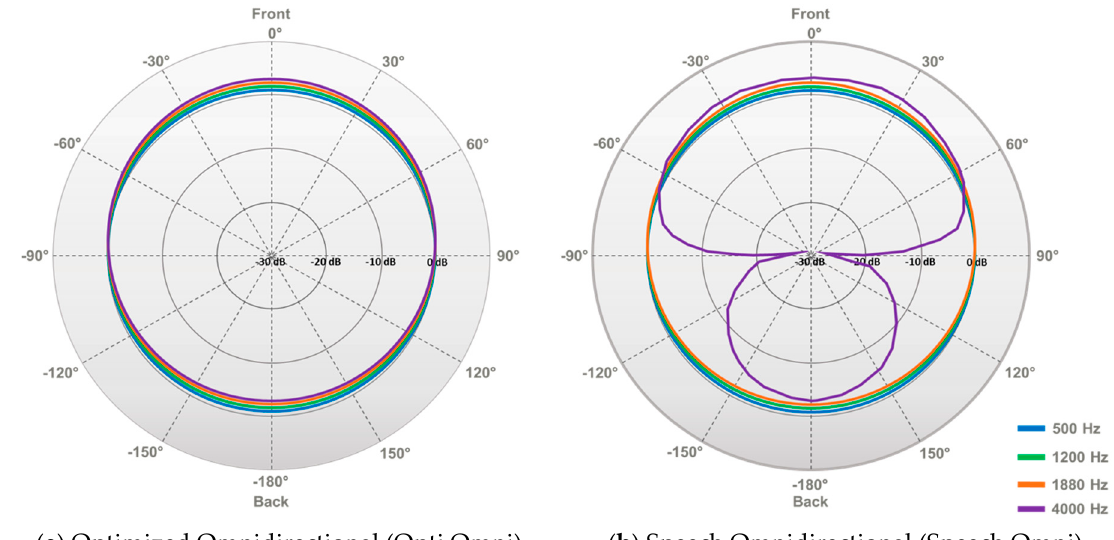
Figure 1. Polar patterns of the two modes ( a ) Optimized Omnidirectional (Opti Omni) and ( b ) Speech Omnidirectional (Speech Omni). Note that (0 azimuth is at the top and that the two plots are normalized re. 90 azimuth. ( a ) In the Opti Omni mode, sensitivity to all angles of arrival is equal, except that sounds originating from the back, regardless of frequency, are slightly attenuated compared to sounds originating from the front (mild front advantage). ( b ) In the Speech Omni mode, the microphone response is the same as Opti Omni in the low frequencies. In the high frequencies (cut-off frequency of 1.88 kHz), the directional microphones attenuate sounds originating from the back.